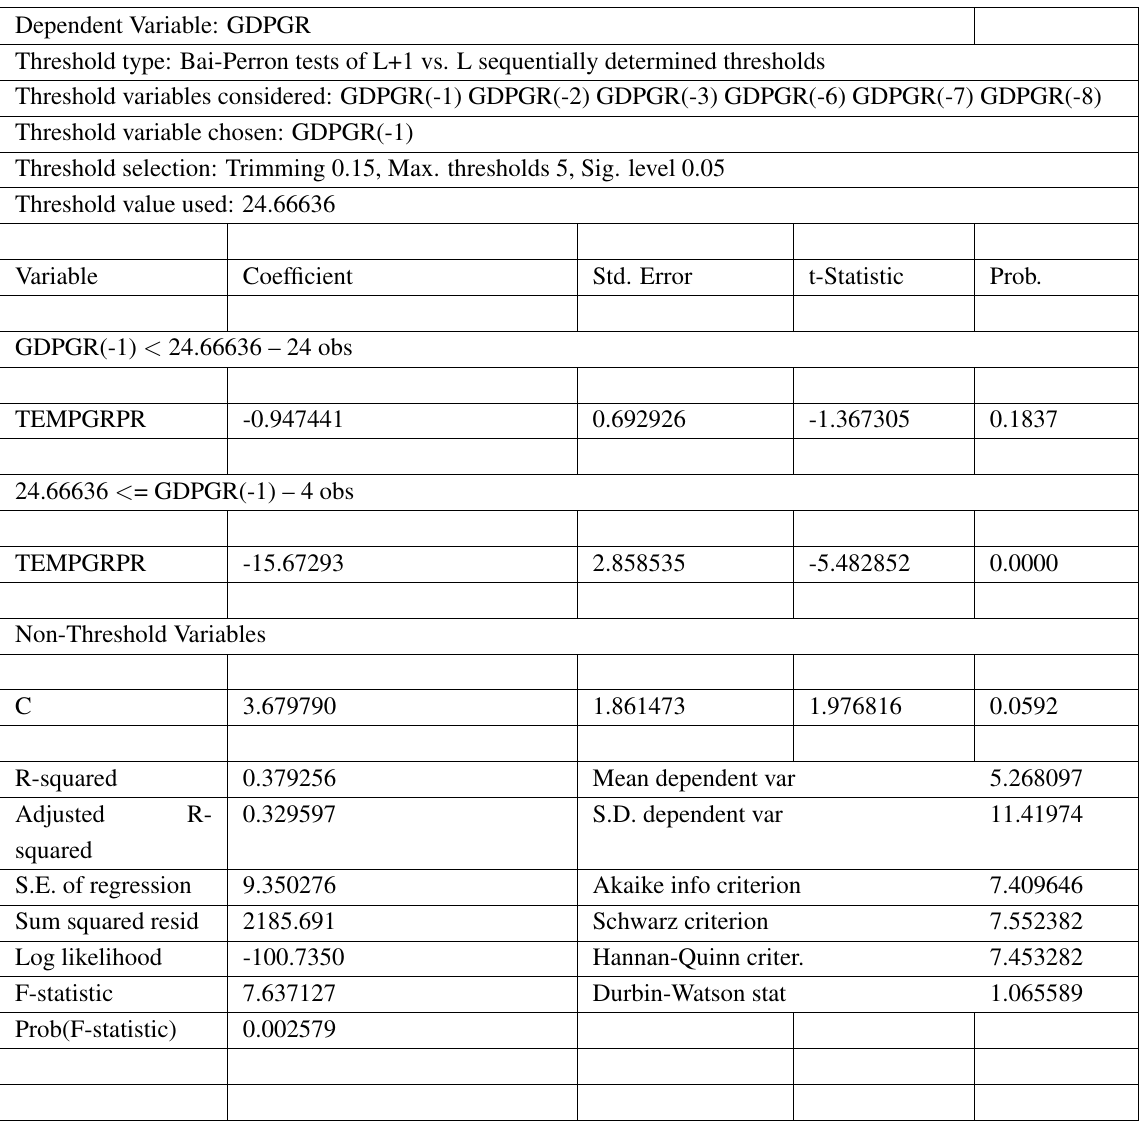
Table 1. Environmental-Economic Growth Threshold